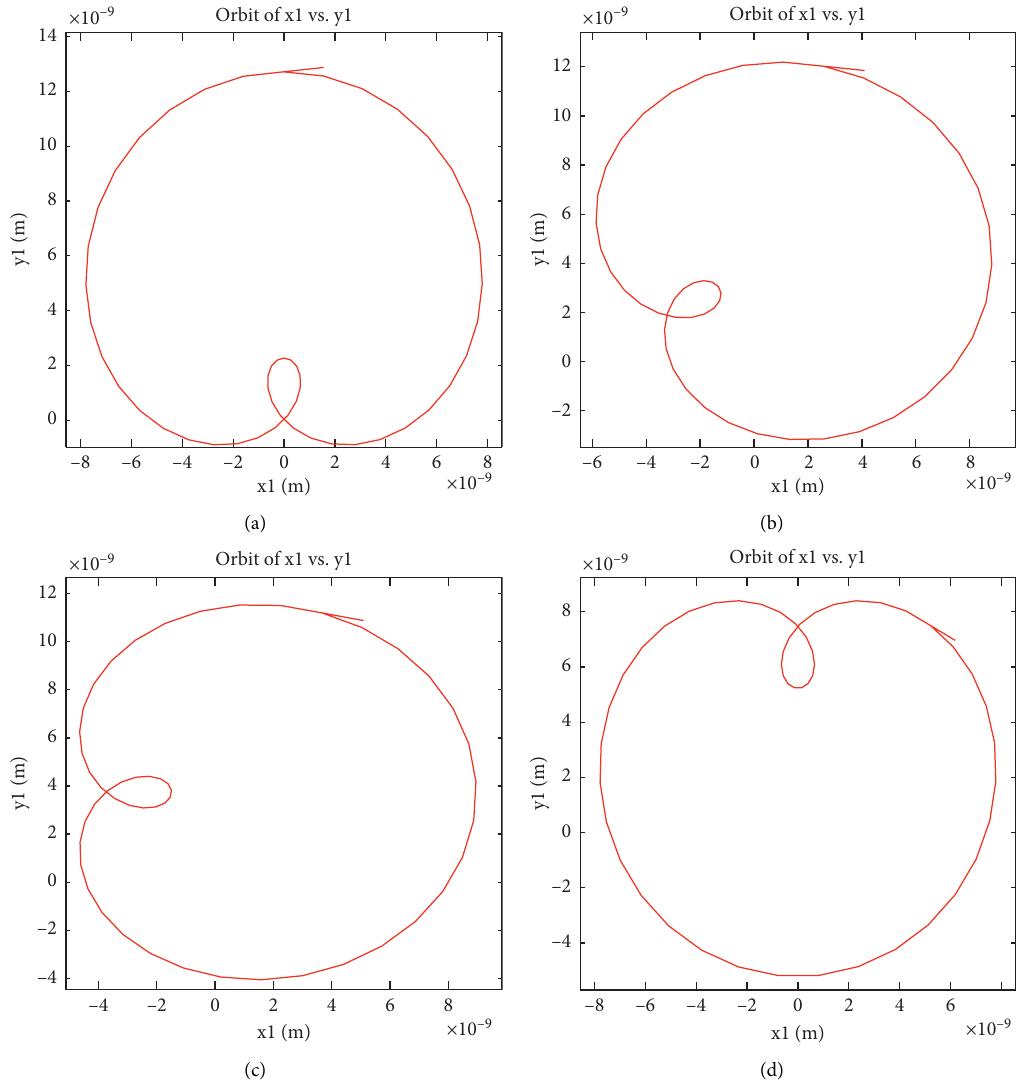
Figure 19: Effects of phase shift on the phase diagram between x